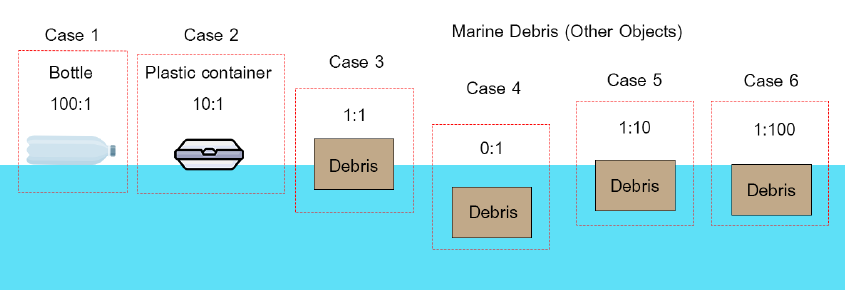
Figure 3. Operational Diagram.